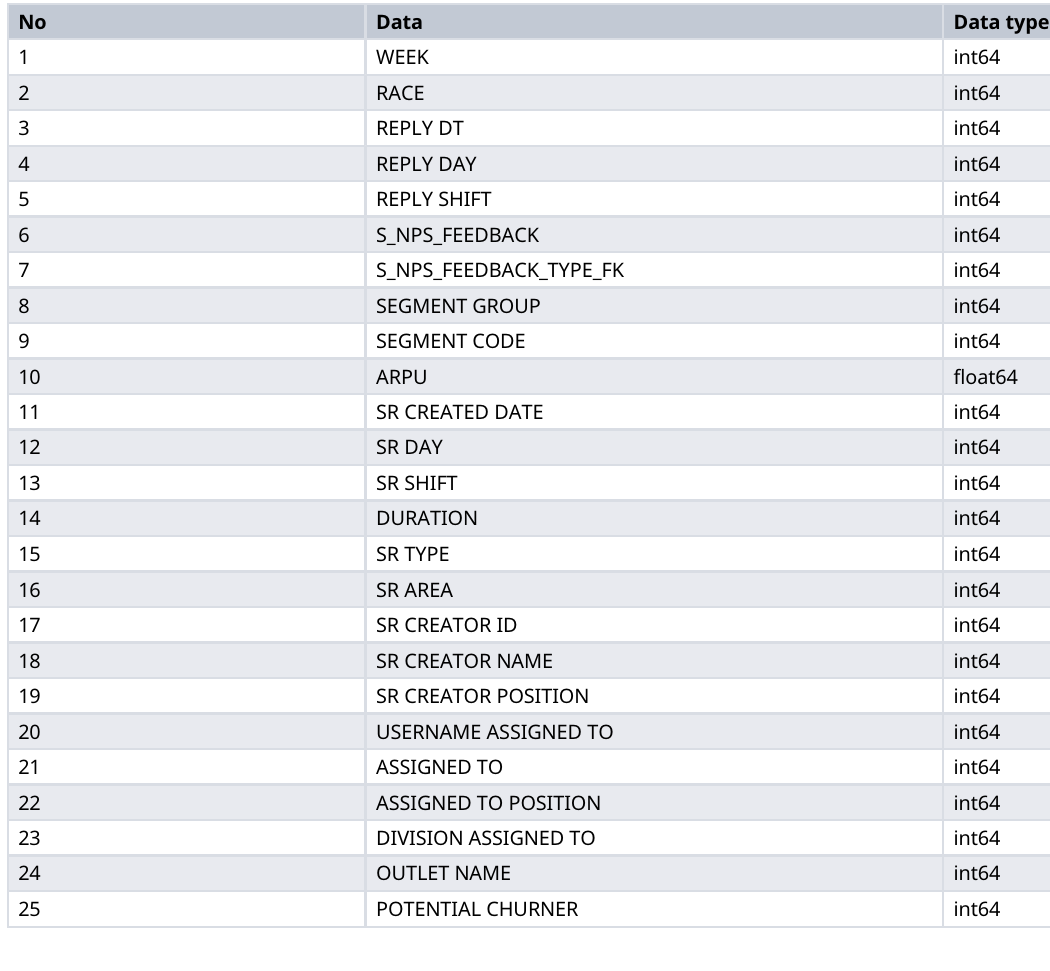
Table 12. Variable selection and transformation.